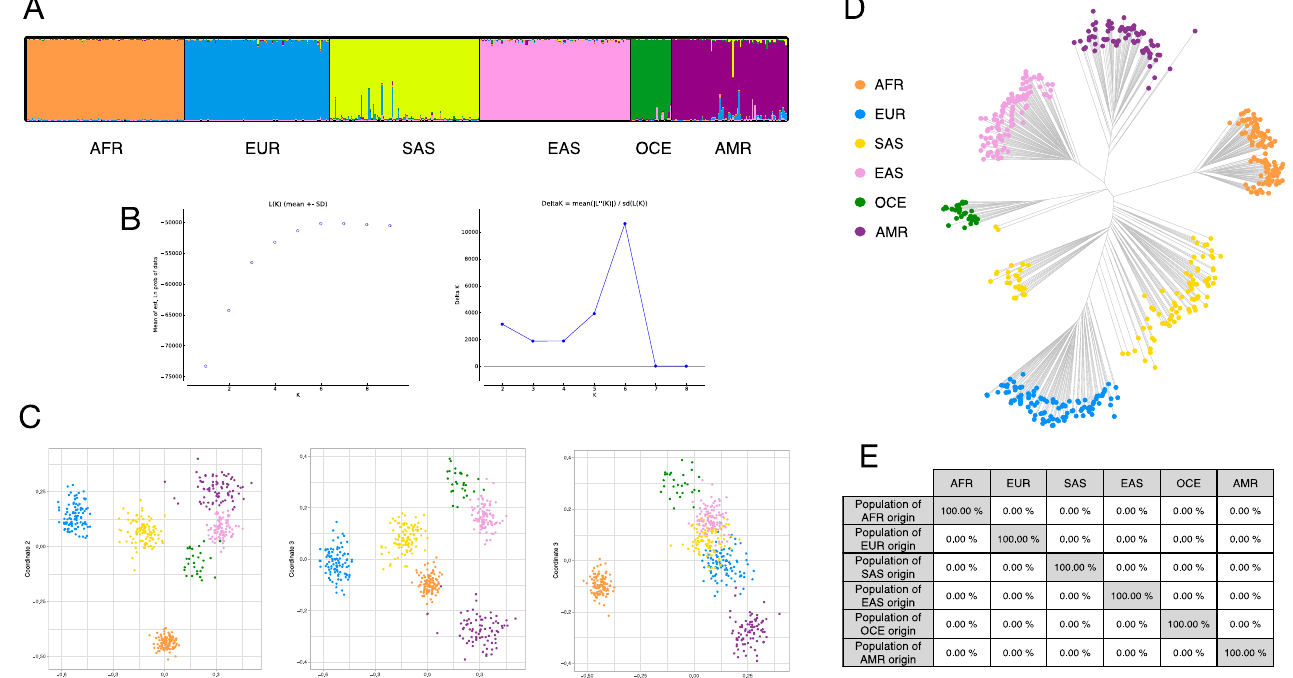
Figure 3. Ancestry analysis with 115 BT ancestry SNPs of the six populations of the standardised reference dataset (AFR: brown; EUR: blue; SAS: yellow; EAS: pink; OCE: green; AMR: purple), with consistent colours across three statistical analyses of A, C and D. ( A ) STRUCTURE cluster membership proportions at K = 6, indicated to be the optimum K number of genetic clusters by: ( B ) the mean L(K) (log probability of data) and ∆ K plots from STRUCTURE runs, following the analyses of Evanno et al. [31]. ( C ) Multi-dimensional scaling (MDS) analysis showing principal component (PC) 1 vs. PC2 coordinates, PC1 vs. PC3 and PC2 vs. PC3 two-dimensional plots. ( D ) Neighbour joining tree (NJT) analysis. ( E ) Summary classification success table of cross validation of the standardised reference set.